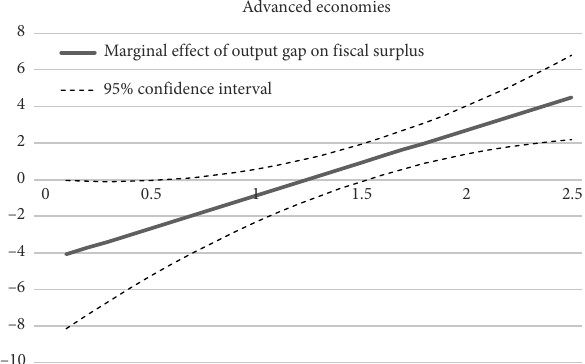
Figure 1. Marginal effect of the output gap on total surplus conditional on government effectiveness in advanced countries